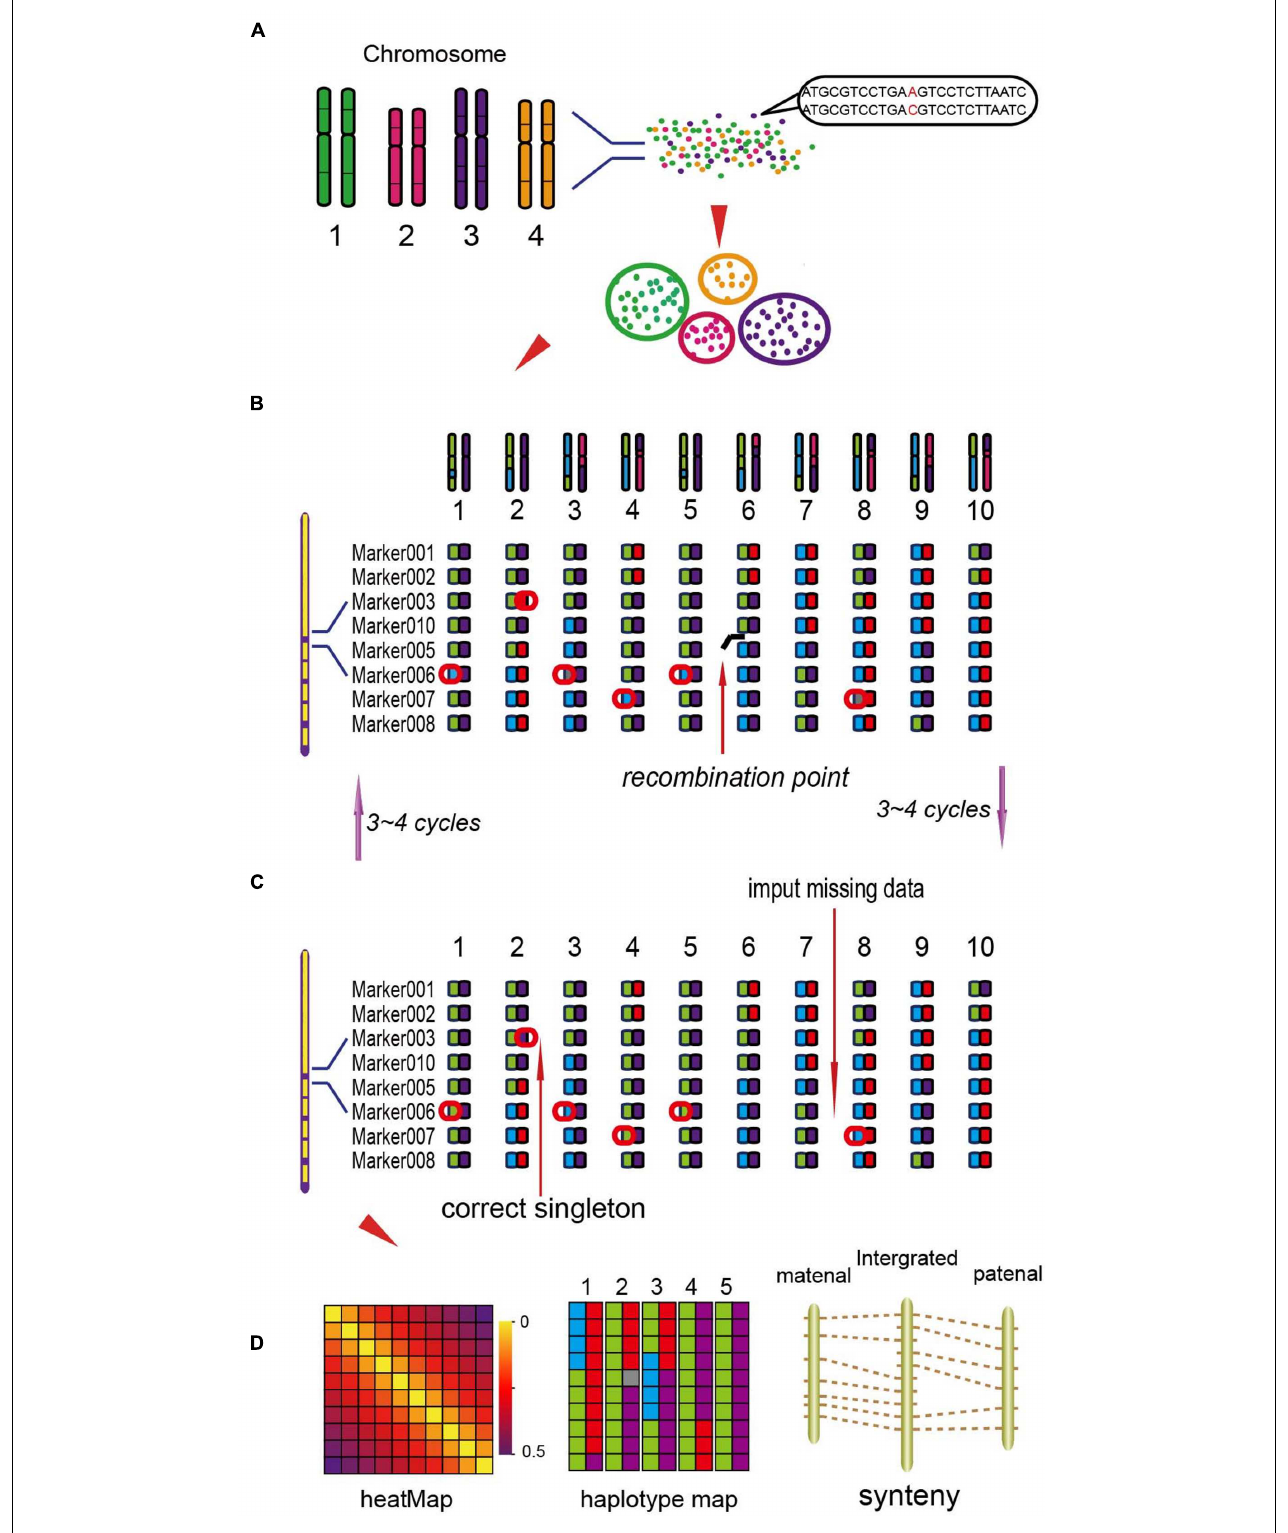
FIGURE 1 | The process of the genetic map construction (Liu et al., 2014). (A) Calculate the mLOD value of the high quality molecular tags, using this value to analysis seven linkage groups (LGs). (B) Using the software of HighMap to construct the genetic map for each LG. (C) According to the result of mapping to correct the tags genotyping. (D) Get the high-density genetic map and evaluate the quality of the map.